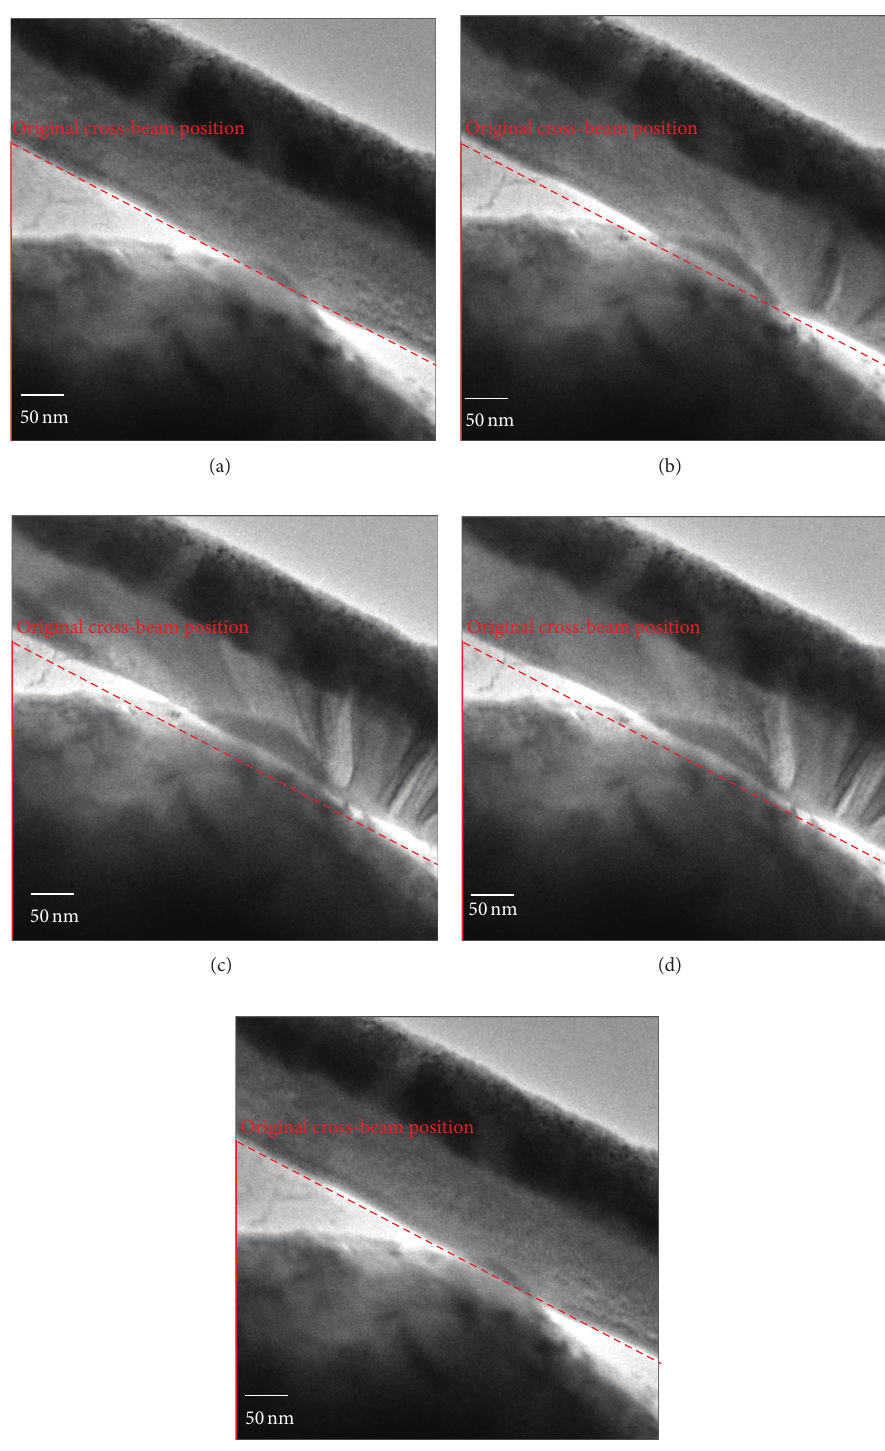
Figure 4: A sequence of images extracted from a video recording of sample I, corresponding to the indentation experiment performed in point (a) to point (e) of Figure 3(a), showing the deformation stages: (a) the GaN nanobeam before loading, (b) at the end of linear loading, (c) the bended nanobeam at peak load, (d) during unloading at the end of nonlinear or plastic deformation, and (e) nearly no residual deformation after full